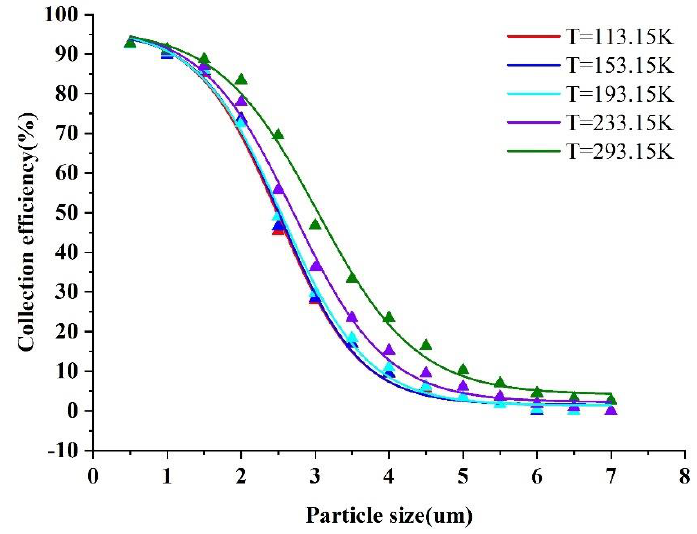
Figure 12. Collection efficiency curves at different temperature (T)